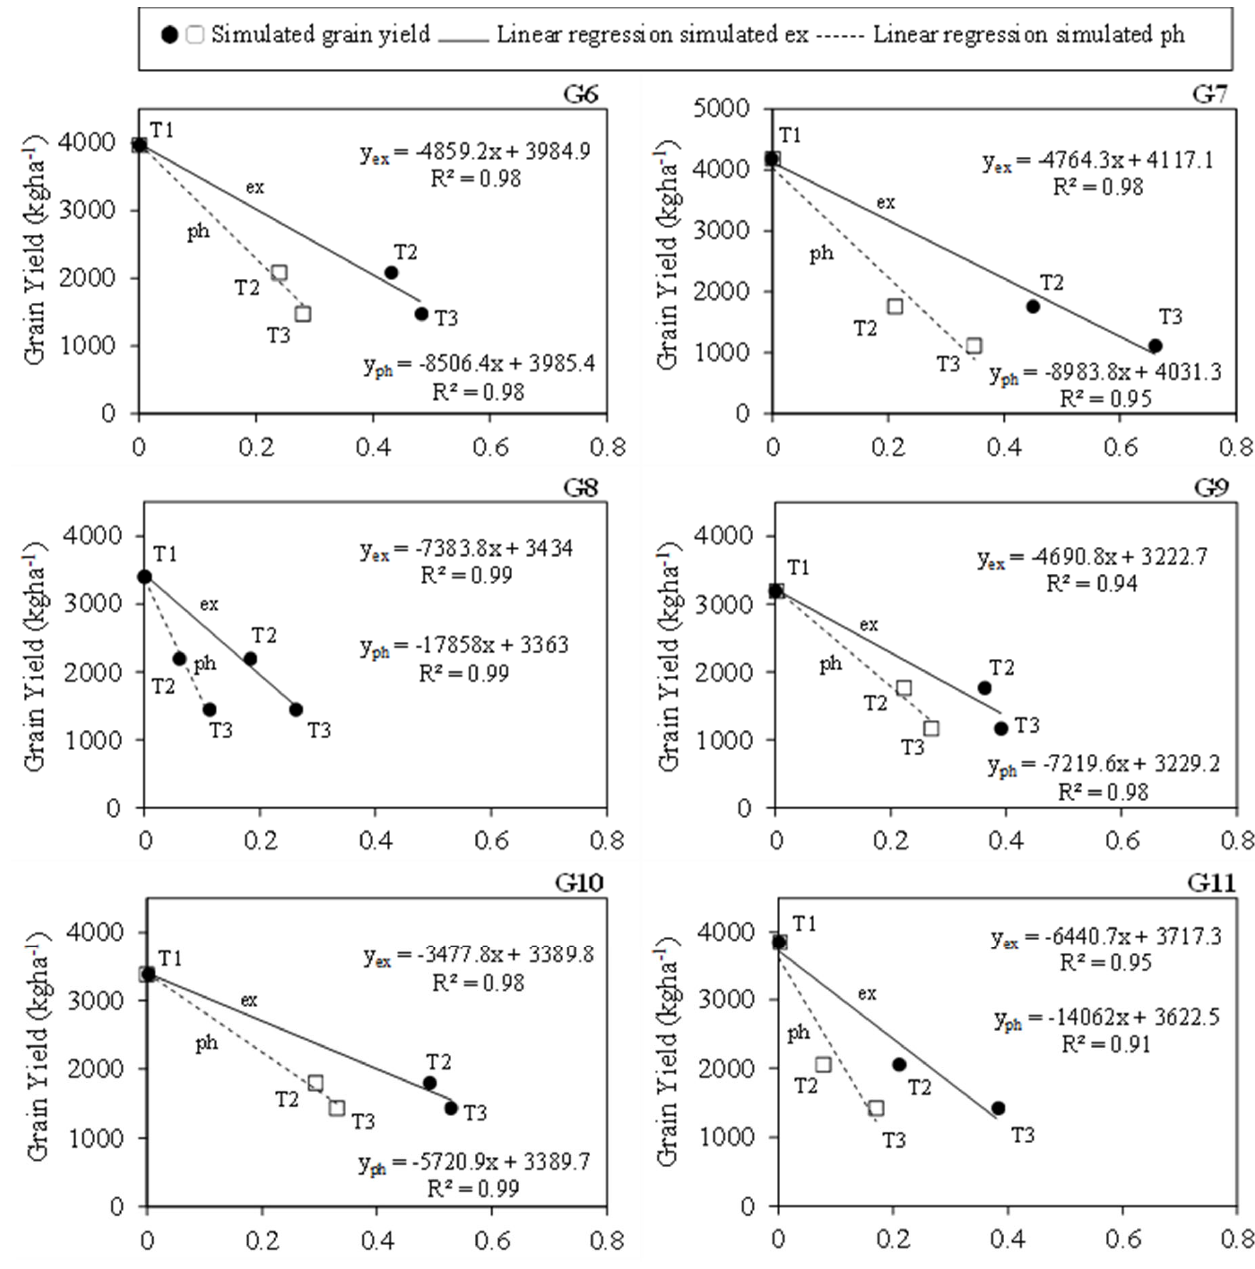
Figure 9. Linear regression relationship between simulated grain yield and average drought stress for photosynthesis (ph), and between simulated grain yield and average drought stress for growth expansion (ex) for genotypes G6–G11 in group B under T1: control (100% FC), T2: moderate stress (70% FC) and T3: severe stress (50% FC) treatments in yield assessment experiment.